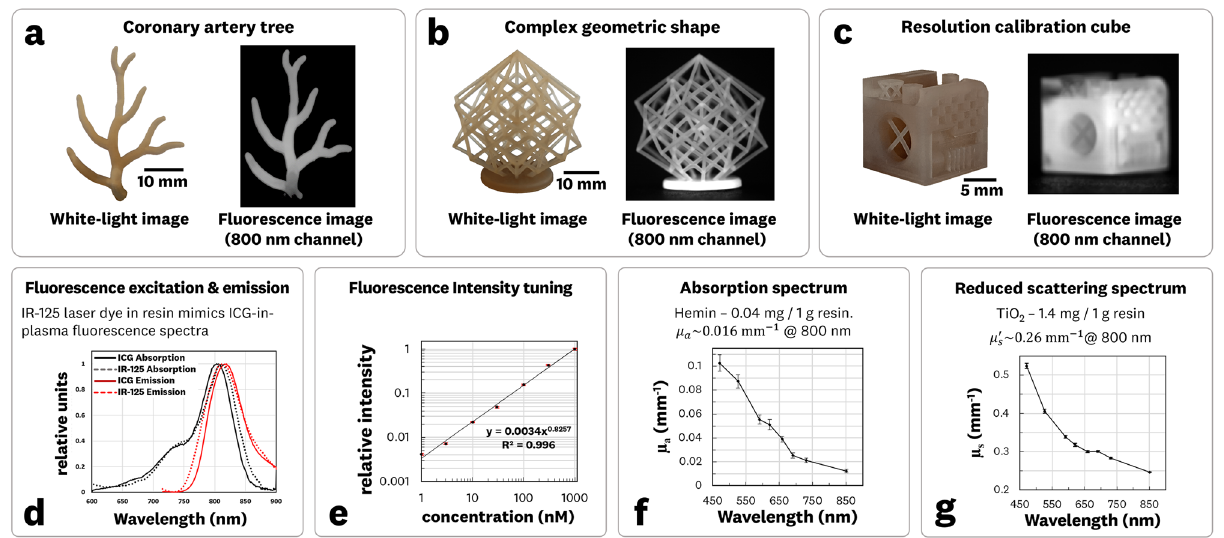
Figure 2. 3D printed ICG-equivalent material with tuned optical properties. ( a–c ) White-light and 800 nm channel fluorescence images of ( a ) MRI-scanned coronary artery tree structure, ( b ) complex geometrical lattice cube, and ( c ) resolution calibration cube with sub-200 μm feature sizes. ( d ) Fluorescence emission and excitation spectra of 3DP fluorescent material and ICG-in plasma showing close overlap in spectral features. ( e ) Linearity of fluorescent intensity output for increasing laser-dye concentrations in 3DP material. ( f, g ) Measured absorption and reduced scattering coefficient spectra of the 3DP material. Error bars indicate ± one standard deviation from the